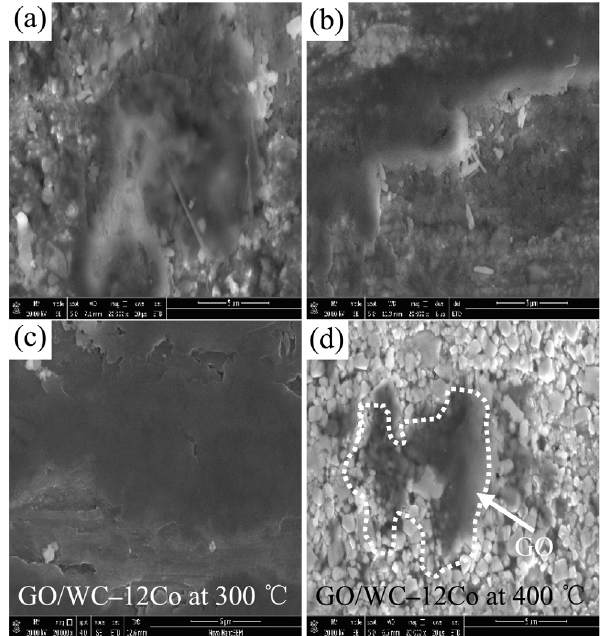
Fig. 15 Graphene in wear tracks formed in the GO/WC–12Co coatings during high-temperature wear.